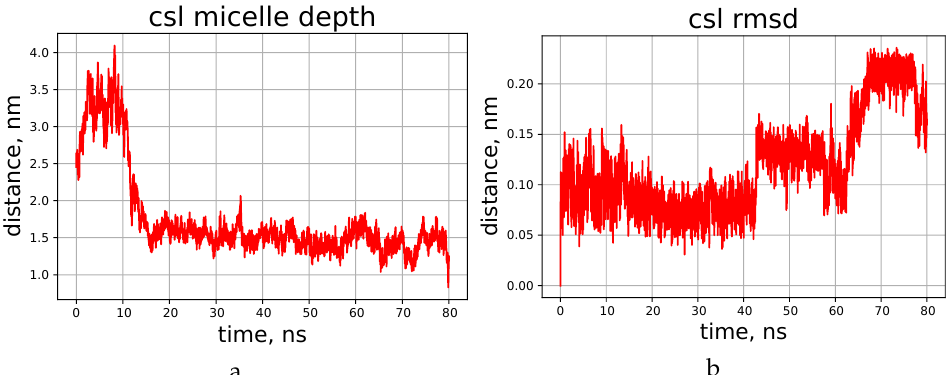
Figure 4. Time dependence of the distance from the peptide to the micelle’s center ( a ) and RMSD of the backbone atom positions ( b ), according to the simulations of cyclosporin